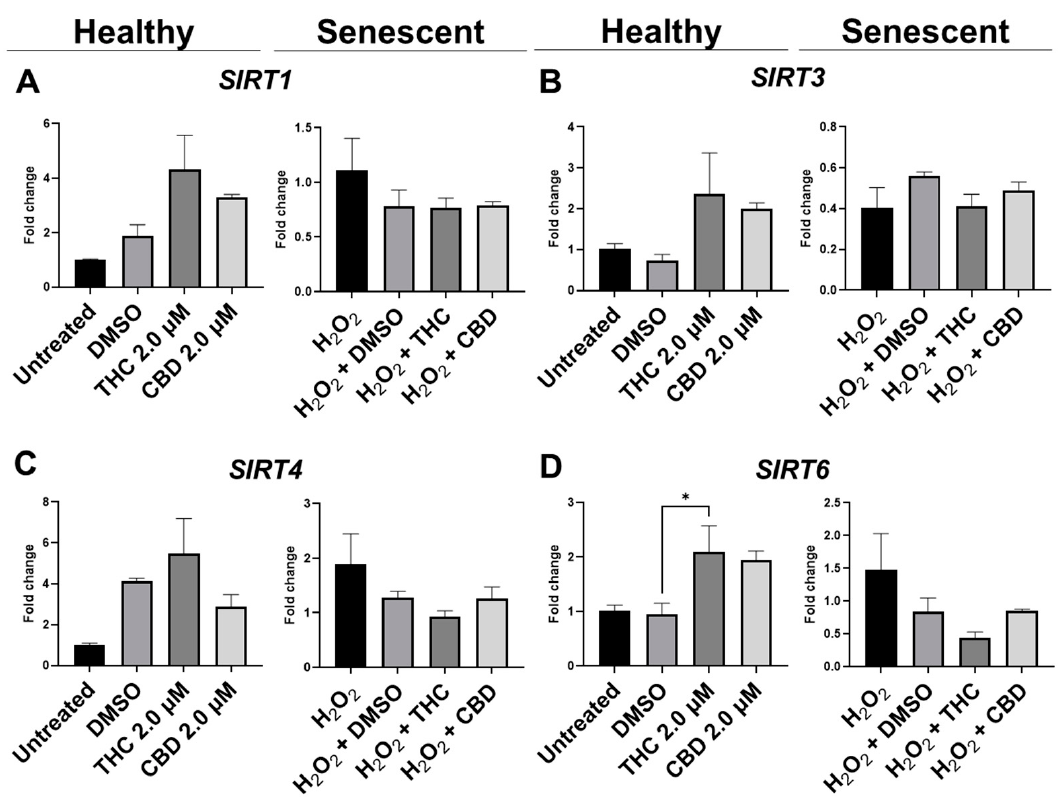
Figure 10. Effects of phytocannabinoids on mRNA levels of metabolic regulators in CCD-1064 human dermal fibroblasts. mRNA levels were presented as a ratio of the target gene relative to GAPDH for expression of ( A ) SIRT1 , ( B ) SIRT3 , ( C ) SIRT4 , and ( D ) SIRT6 . Data were analyzed with an ANOVA test followed by a Dunnett’s post-hoc multiple comparison test compared to the vehicle. Bars represent mean ± SEM, n = 3. CBD, cannabidiol; DMSO, dimethyl sulfoxide (vehicle); THC, delta-9-tetrahydrocannabinol. The asterisk shows significant difference ( p <